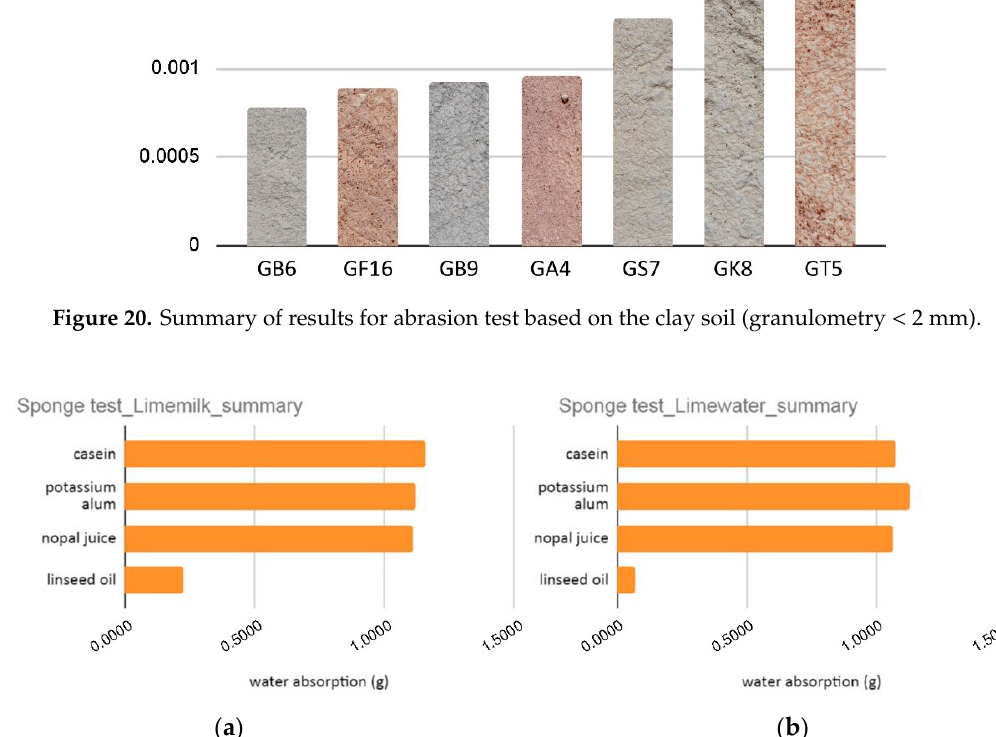
Figure 21. Summary of results for absorption test for ( a ) Limemilk and ( b ) Limewater with four natural stabilizers.